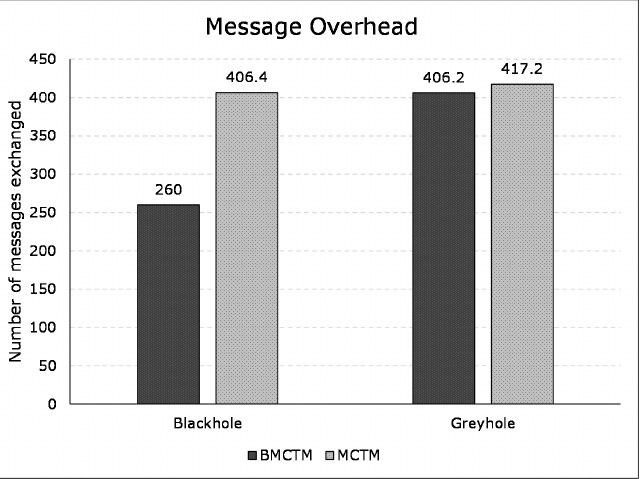
Figure 7. Message overhead in BMCTM and Mobile Code-driven Trust Mechanism (MCTM) in blackhole and greyhole attack scenarios.